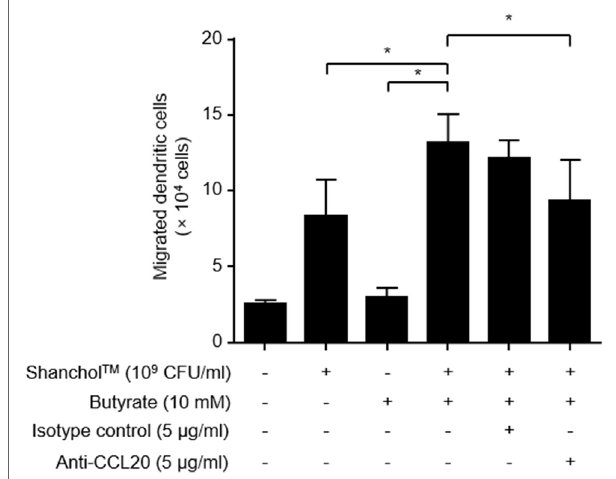
FigUre 6 | Co-treatment with Shanchol ™ and butyrate induces chemotactic migration of human immature dendritic cells (DCs). Caco-2 cells were stimulated with Shanchol ™ (10 9 CFU/ml) in the presence or absence of butyrate (10 mM) for 24 h. After that, the culture supernatants were pre-incubated with indicated concentration of anti-CCL20-neutralizing antibody or isotype control for 30 min. Immature DCs were placed in the upper chamber and further incubated for 1.5 h. The migrated DCs in the lower chamber were counted using trypan blue staining. All results are expressed as mean ± SD of triplicate samples. The asterisk (*) indicates a statistically significant difference ( P < 0.05) compared with the appropriate control.